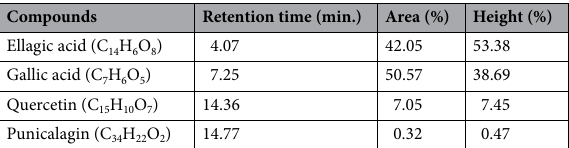
Table 2. HPLC chromatograms of phenolic standards (ellagic acid, gallic acid, quercetin, and